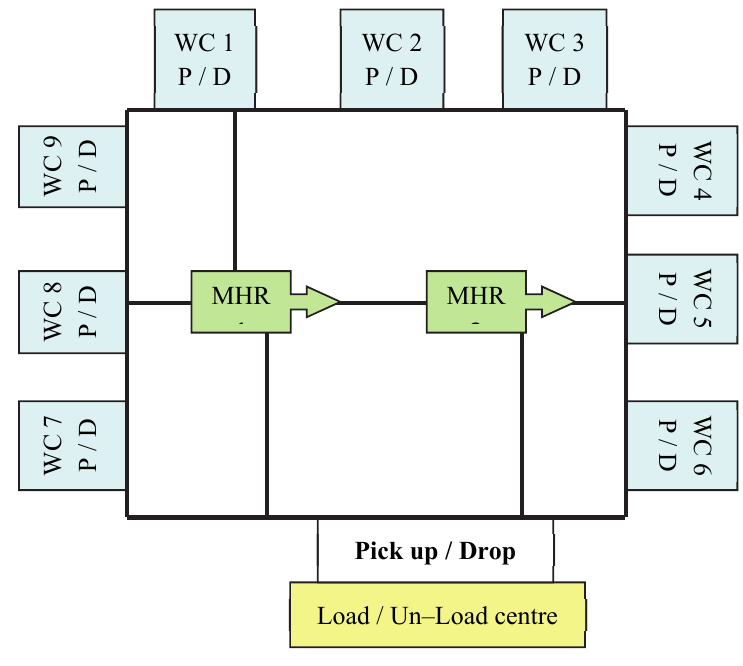
Fig. 4: The FMS layout 3 constituting 9 work center and one load-unload